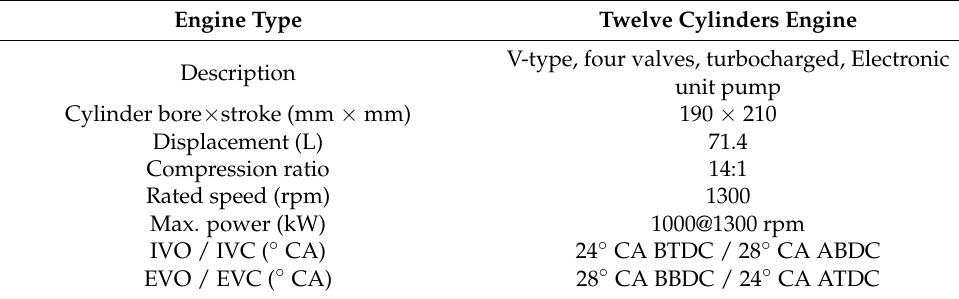
Table 1. Specifications of the engines.